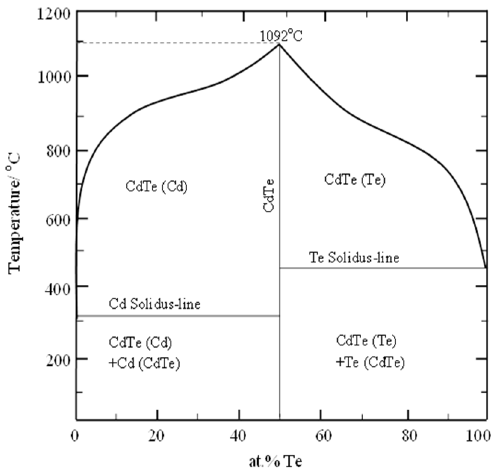
Figure 15. Phase diagram showing the melting point of CdTe as a function of its composition. Re-drawn from